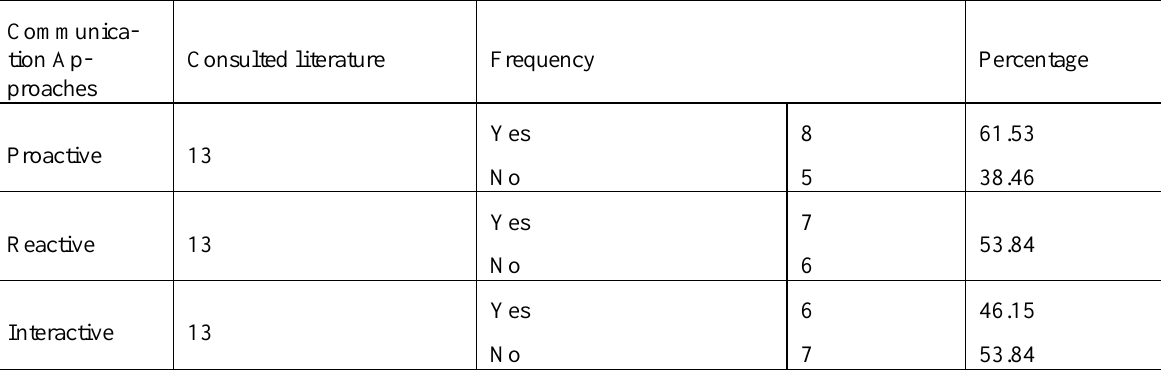
Table 2: Shows the nature of the use of the three communication approaches by NHIS.